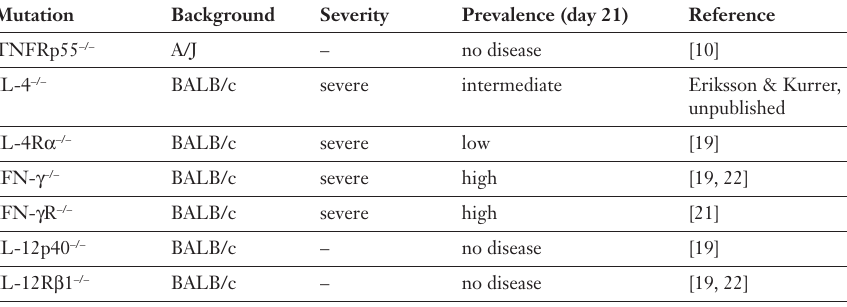
Table 1 Myocarditispreva- lence and severity in cytokine and cytokine receptor knock-out